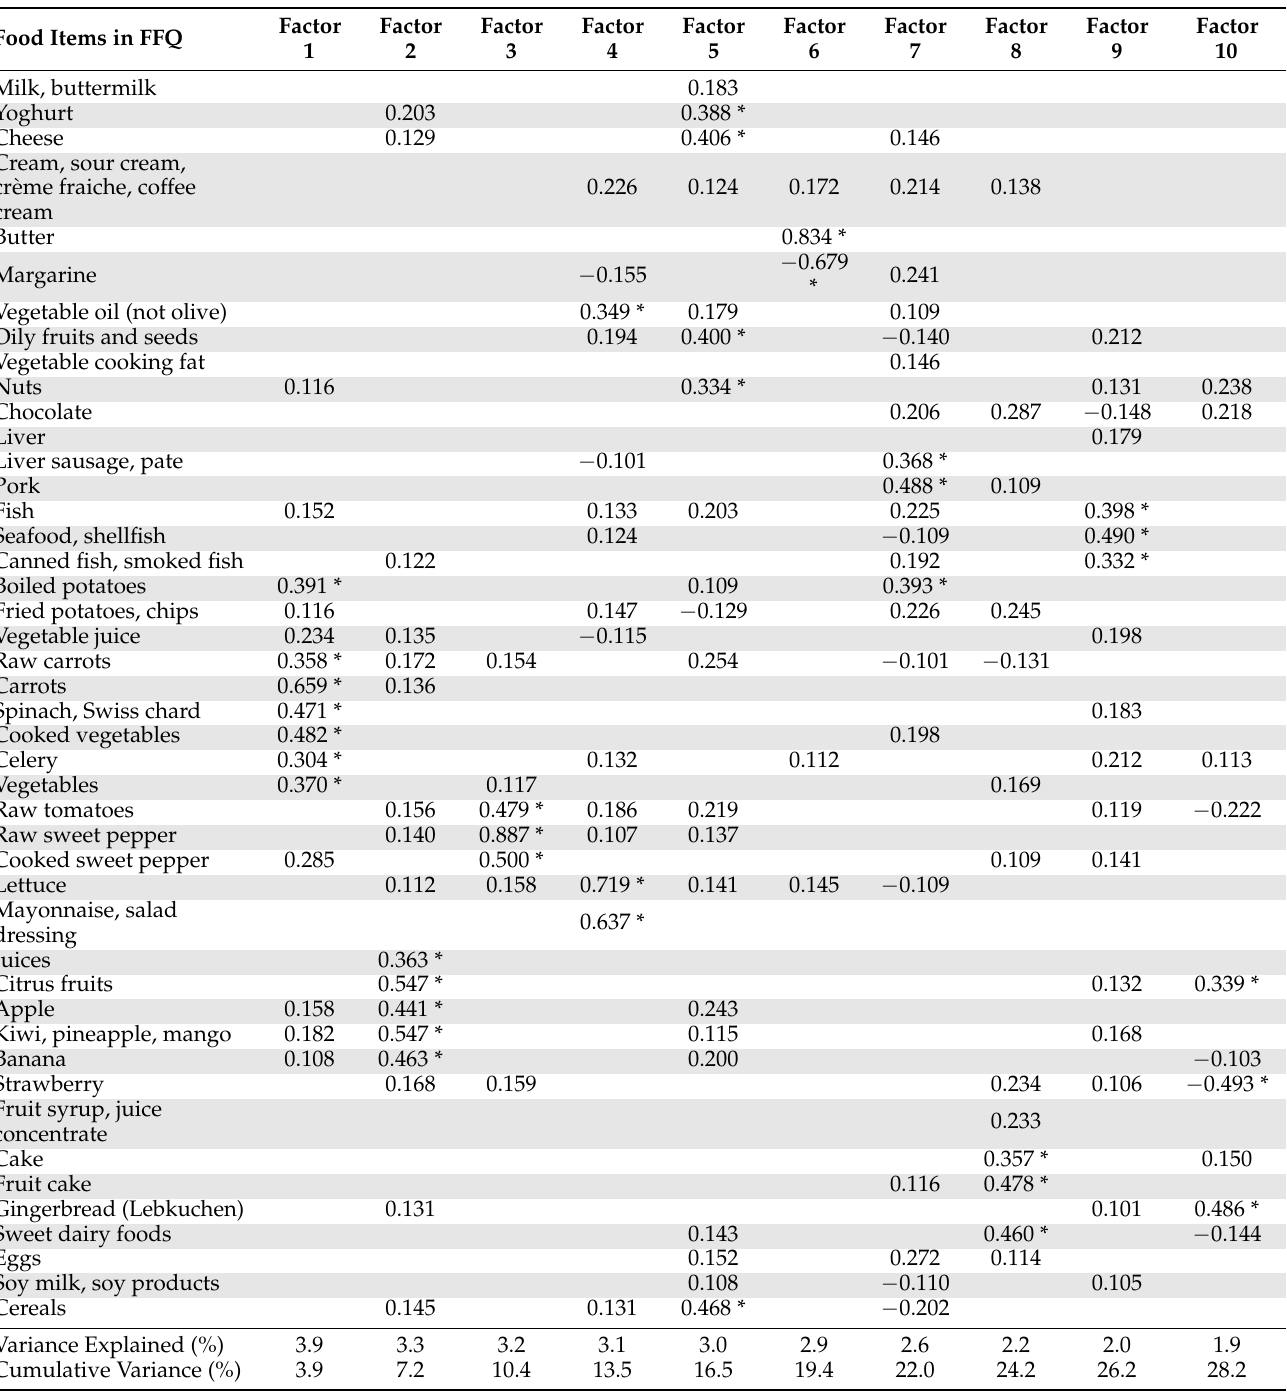
Table 2. Food item factor loadings from factor